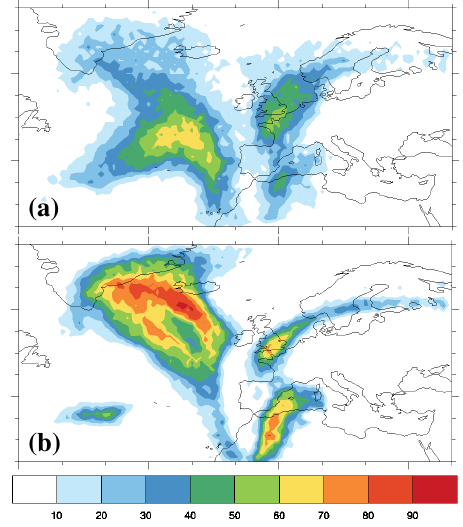
Figure 1. Total column probability of WCB occurrence (%), as available during TNF. Probabilities are computed from ABL-started trajectories filtered for an ascent of 500hPa in 48h. Forecasts from (a) 00:00UTC, 15 October 2012 and from (b) 00:00UTC, 17 Oc- tober 2012, both valid at 18:00UTC, 19 October 2012. Compare to Fig. 3 in Schäfler et al.